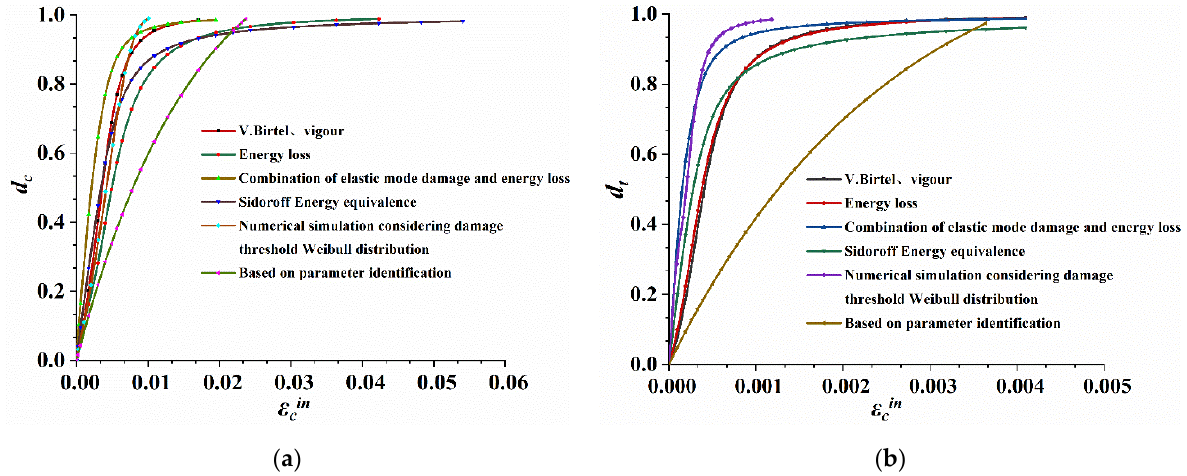
Figure 5. Damage factor and inelastic strain. ( a ) Compression damage factor inelastic strain. ( b ) Tension damage factor